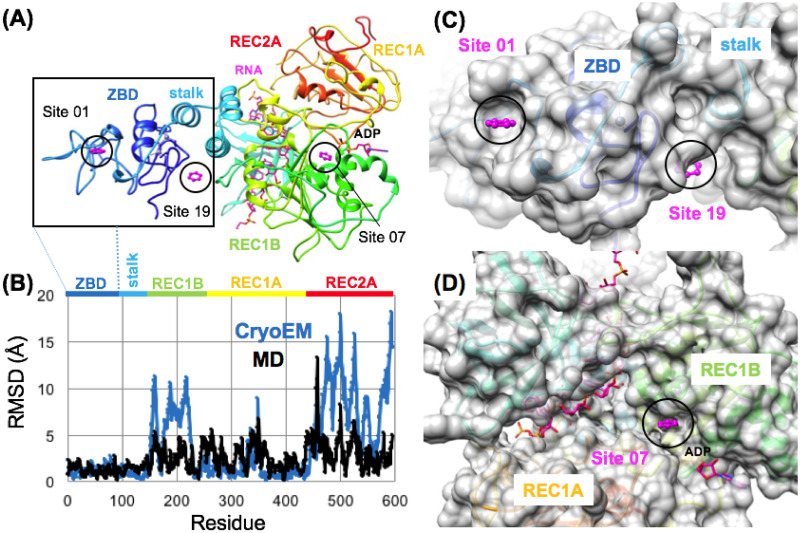
Domain structure and favorable aromatic pharmacophore sites on the Nsp13 helicase.Nsp13 structure is shown in a rainbow ribbon diagram in (A) where the N-terminal zinc-binding-domain (ZBD) is colored blue and the C-terminal REC2A domain is colored red. Favorable binding sites Site 01, Site 19 and Site 07 are highlighted in magenta and labeled. The location of RNA and ADP binding are modeled onto the structure via a structural alignment of another eukaryotic helicase (2xzl.pdb) bound to RNA and ADP. In (B) the root-mean-squared-deviation (RMSD) calculated between two recent Nsp13 helicase structures captured in different conformational states in a CryoEM structure of a complete SARS-CoV-2 replicase complex is shown in (blue). A similar RMSD as a function of residue plot is shown for 500 ps of standard molecular dynamics (MD) simulation of the (6jyt.pdb) structure at 310 K in all-atom solvent (black). Favorable binding sites Site 01, Site 19 and Site 07 are highlighted in magenta and shown bound to the Nsp13 helicase surface in (C) and (D) where Site 01 is the most favorable site on the entire Nsp13 helicase found on the N-terminal ZBD (C), where Site 07 was the most favorable site identified in the vicinity of the ATPase active site (D).